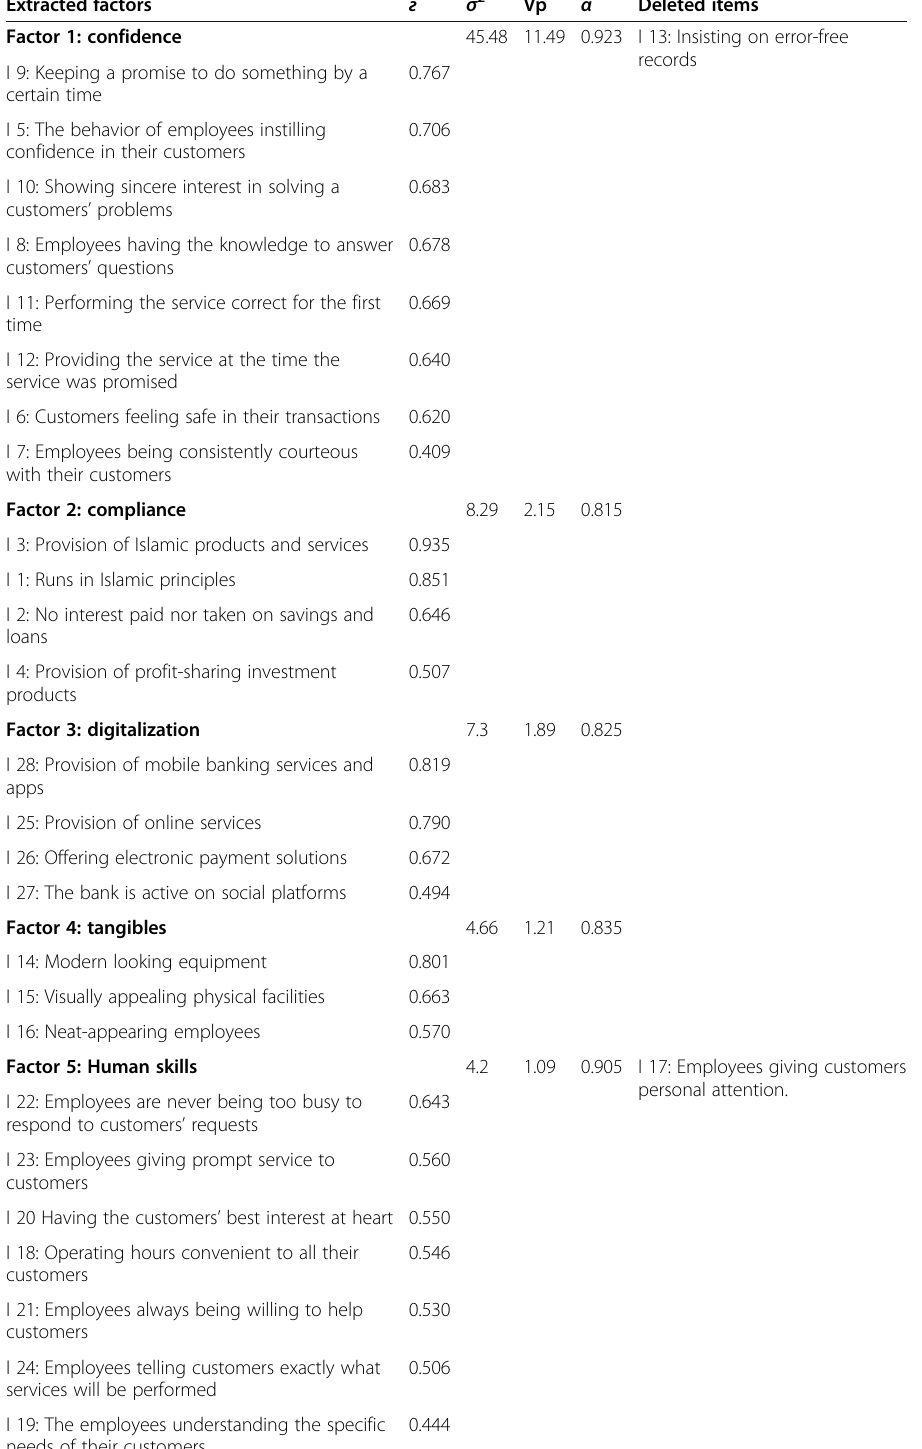
Table 5 Factors, factor loadings and reliabilities for quality